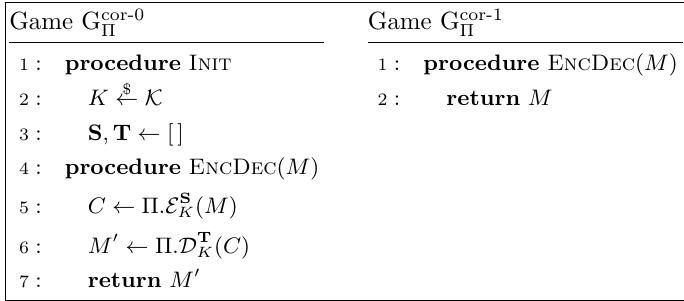
Figure 2: Games defining correctness without reordering of an LPSE scheme Π. Game G cor-wr-0 Π